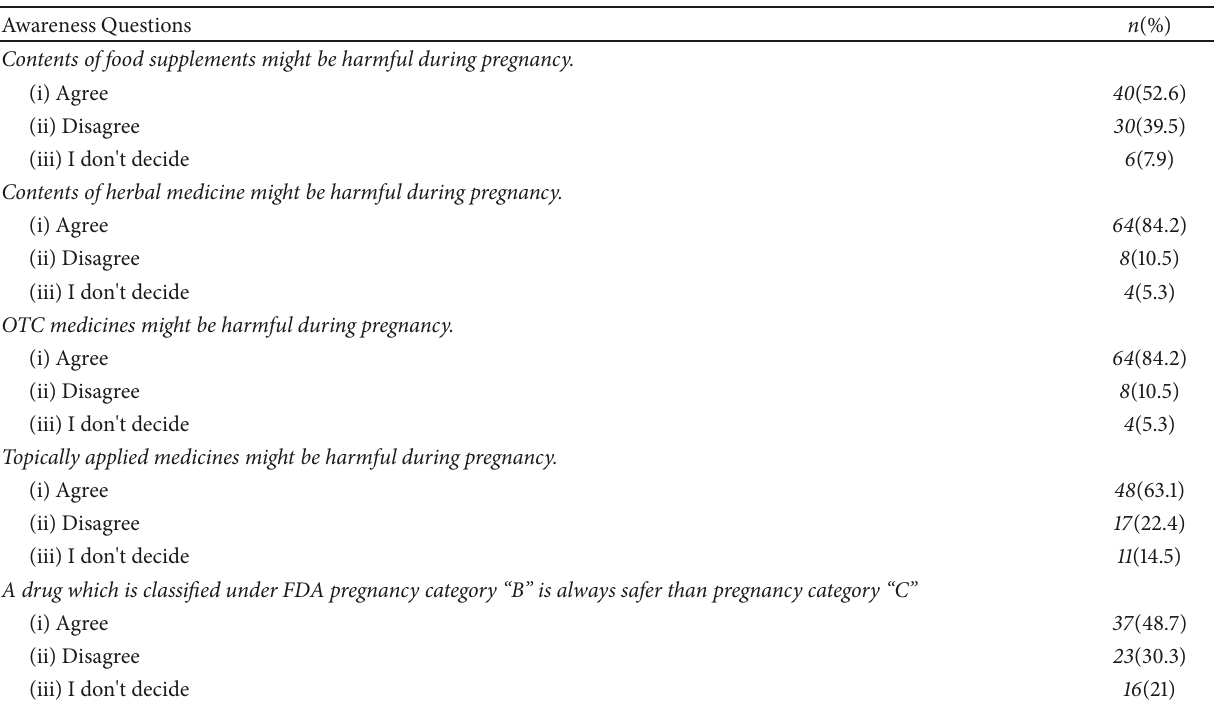
Table 4: Results of awareness test of PPs about self-care of pregnant women . Awareness Questions